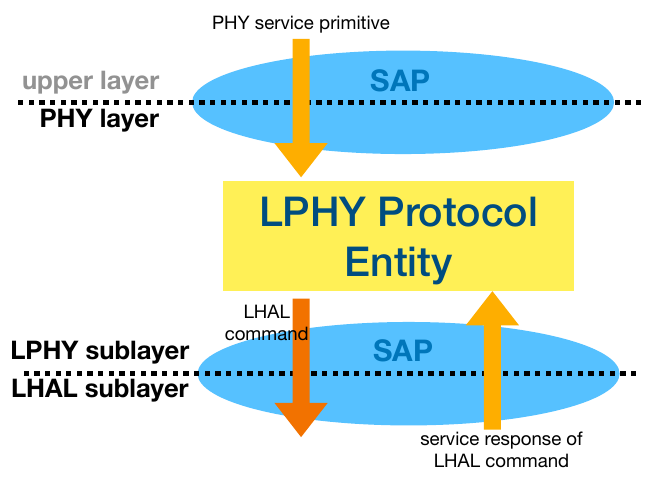
Figure 5. The service access points nearby the